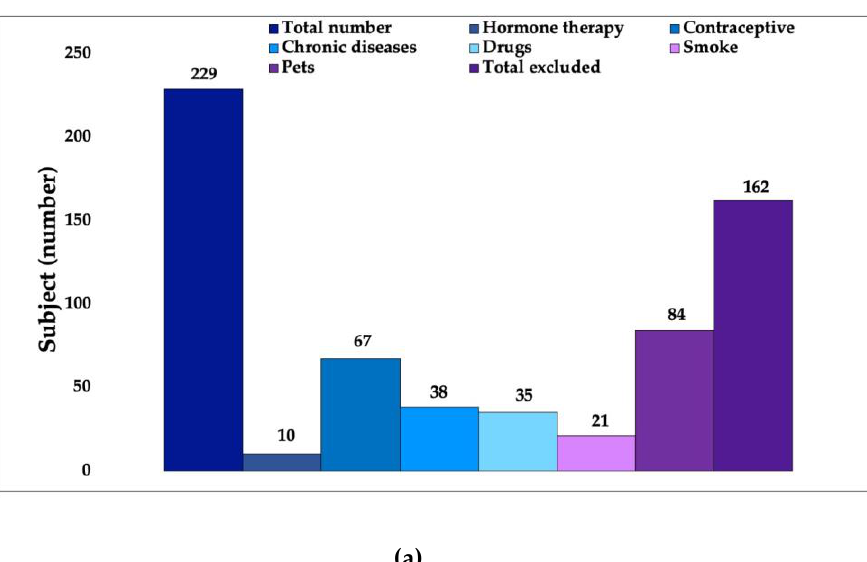
( b ) Figure 3. Results from first phase of study concerning the selection of volunteers on the base of a specific questionnaire: ( a ) based on primary criteria from 229 volunteers, 162 people were excluded; ( b ) based on secondary criteria starting from 67 volunteers, 40 subjects were excluded; thus, 27 women were chosen. 3.2. Instrumental Analysis